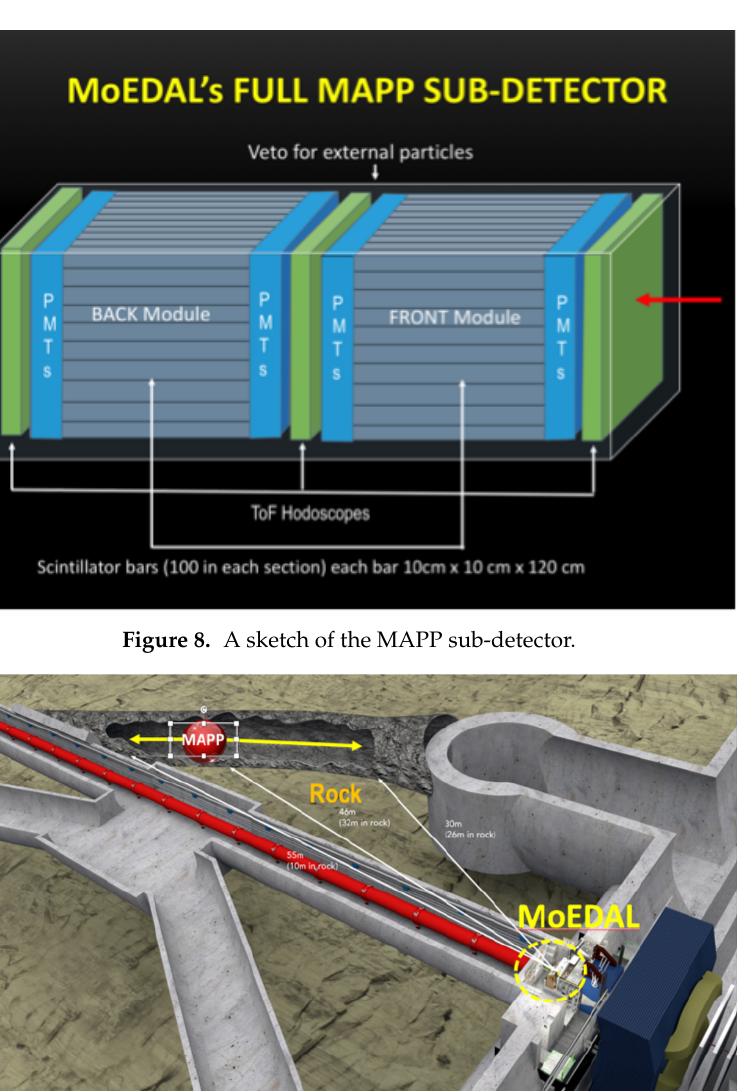
Figure 9. An artists’ impression of the deployment of the MAPP detector in the UGC8 gallery adjacent to the main MoEDAL